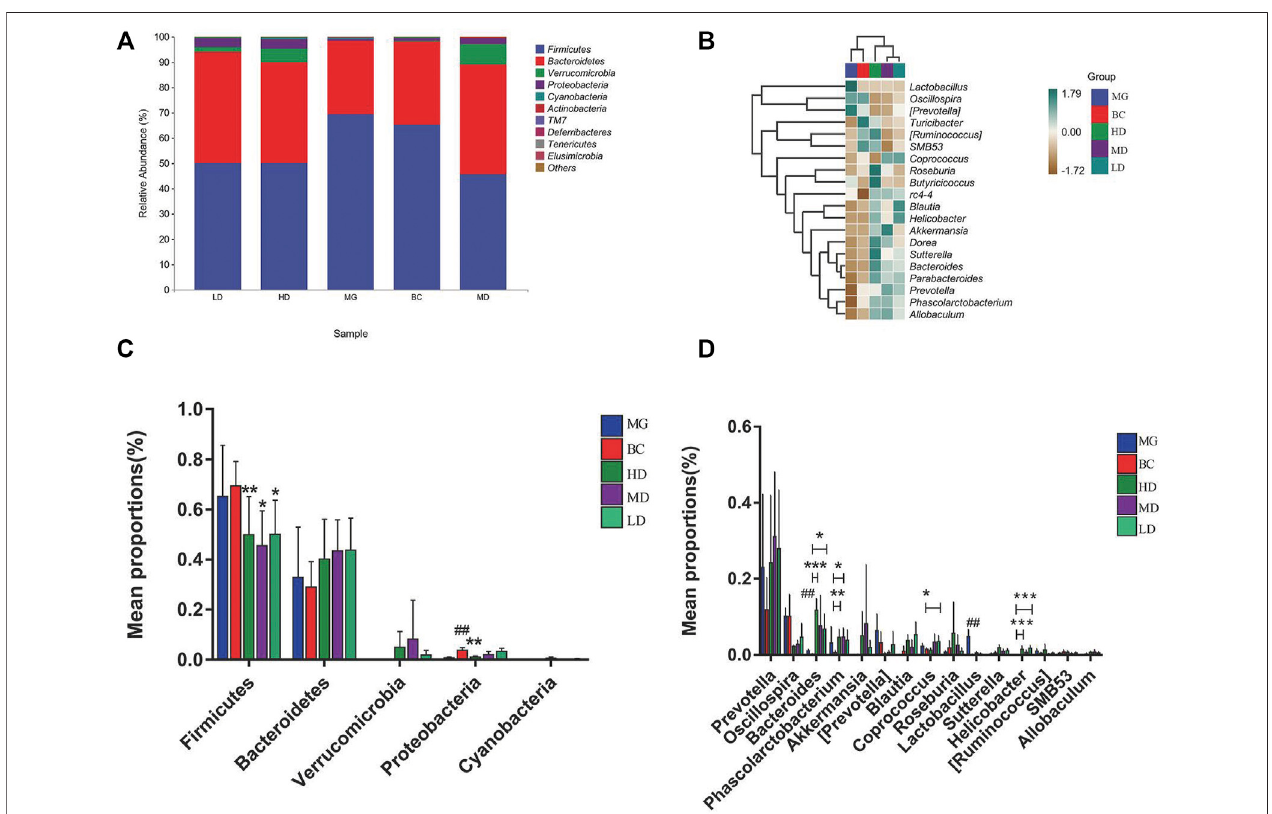
FIGURE 6 | Bacteria with signi fi cant differences in abundance at different taxonomy levels. (A) Relative abundance of microbial species at the phylum level. (B) Heatmap of the relative abundance at the genus level. Differential abundance at the phylum level (C) and genus level (D) . One-way ANOVA, * p < 0.05 and ** p < 0.01, n =